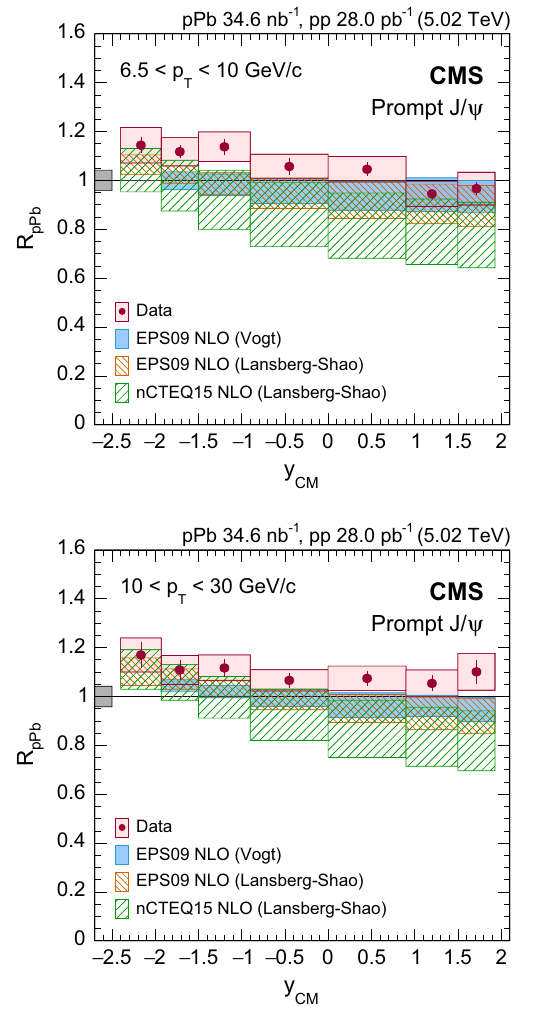
Fig. 5 Rapidity dependence of R pPb for prompt J /ψ mesons in two p T ranges: 6 . 5 < p T < 10GeV / c ( upper ) and 10 < p T < 30GeV / c ( lower ). The vertical bars represent the statistical uncertainties and the shaded boxes show the systematic uncertainties. The fully correlated global uncertainty of 4.2% is displayed as a gray box at R pPb = 1 next to the left axis . The predictions of shadowing models based on the parameterizations EPS09 and nCTEQ15 [14,46–48] are also shown